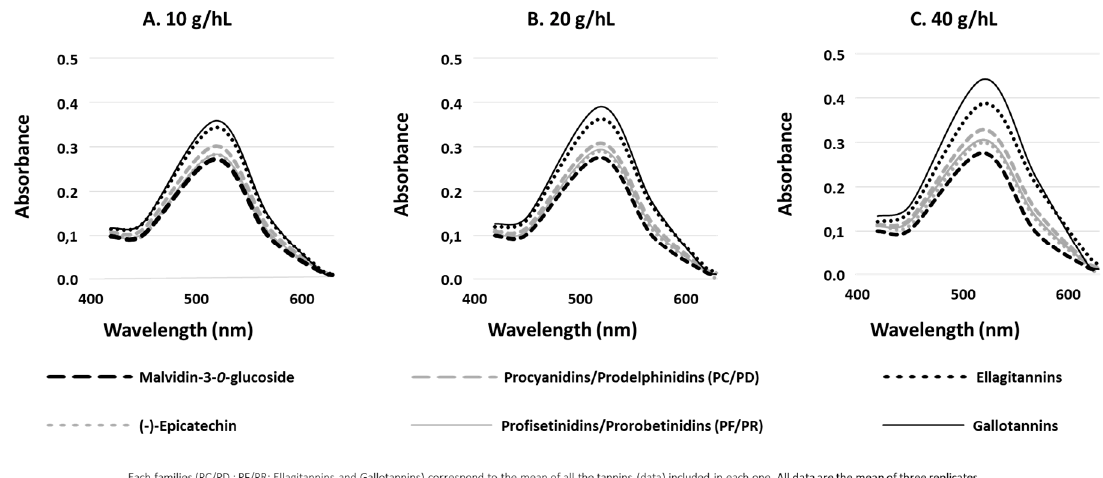
Figure 1. Visible spectra of model wine solution of malvidin-3- O -glucoside (50 mg/L) supplemented with 10 ( A ), 20 ( B ) or 40 ( C ) g/hL of ( − )-epicatechin and oenological tannins after one week of experimentation. The red-greenness (a*), yellow-blueness (b*) and lightness (L*) components of the solutions